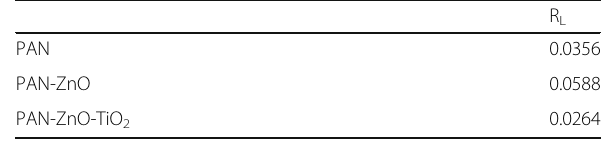
Table 1 Adsorption isotherm parameters for removal of Cr (VI) by nanoparticle decorated PAN based n- fib@Mats Langmuir Freundlich Table 2 R L values of nanoparticle decorated PAN based n-